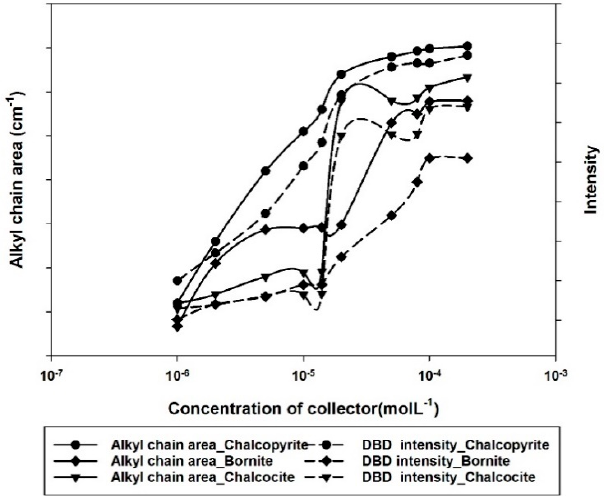
Figure 11. The intensities of the characteristic DBD band and the area under the alkyl chain bands for chalcopyrite, chalcocite and bornite.